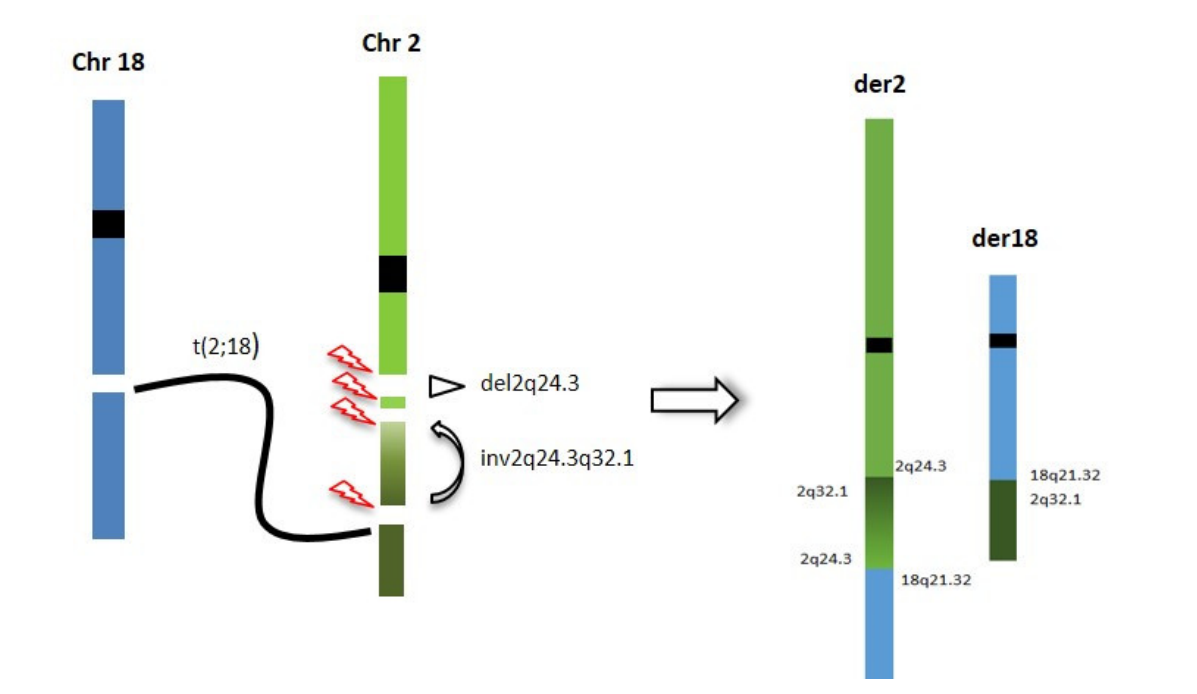
Figure 4. Chromotripsis event underlying the CGR identified in our patient: breakpoints are reported and chromosome segments reshuffling is represented.